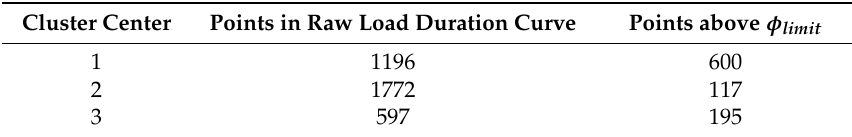
Table 4. Number of points considered for the execution of the multi-objective particle swarm optimization (MOPSO) algorithm.